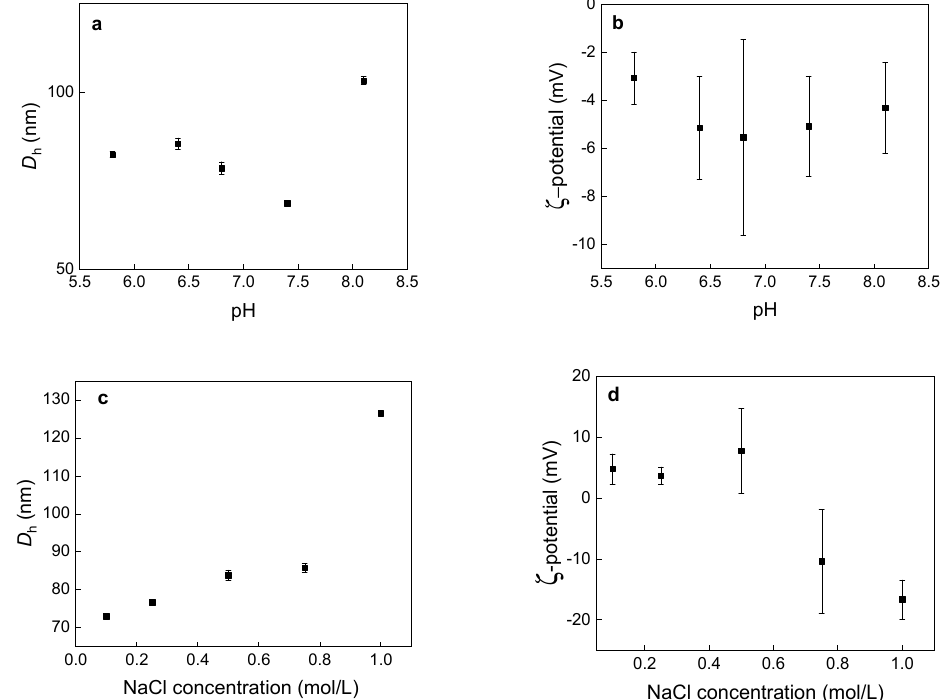
Figure 3. Dependence of ( a , c ) hydrodynamic diameter D h and ( b , d ) ζ -potential of GdF 3 :Tb 3+ ,Yb 3+ ,Nd 3+ @P(DMA-AGME)- Ale nanoparticles on ( a , b ) pH and ( c , d ) NaCl concentration. Table 1. Characterization of the nanoparticles.